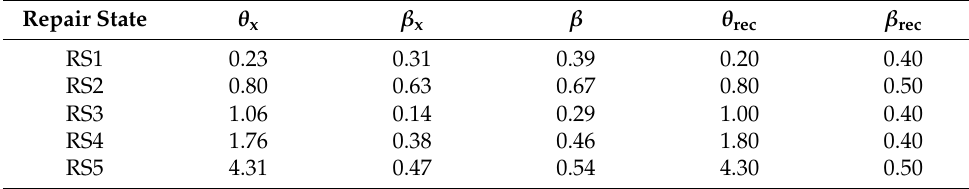
Table 6. Repair state statistics and recommended values (%).